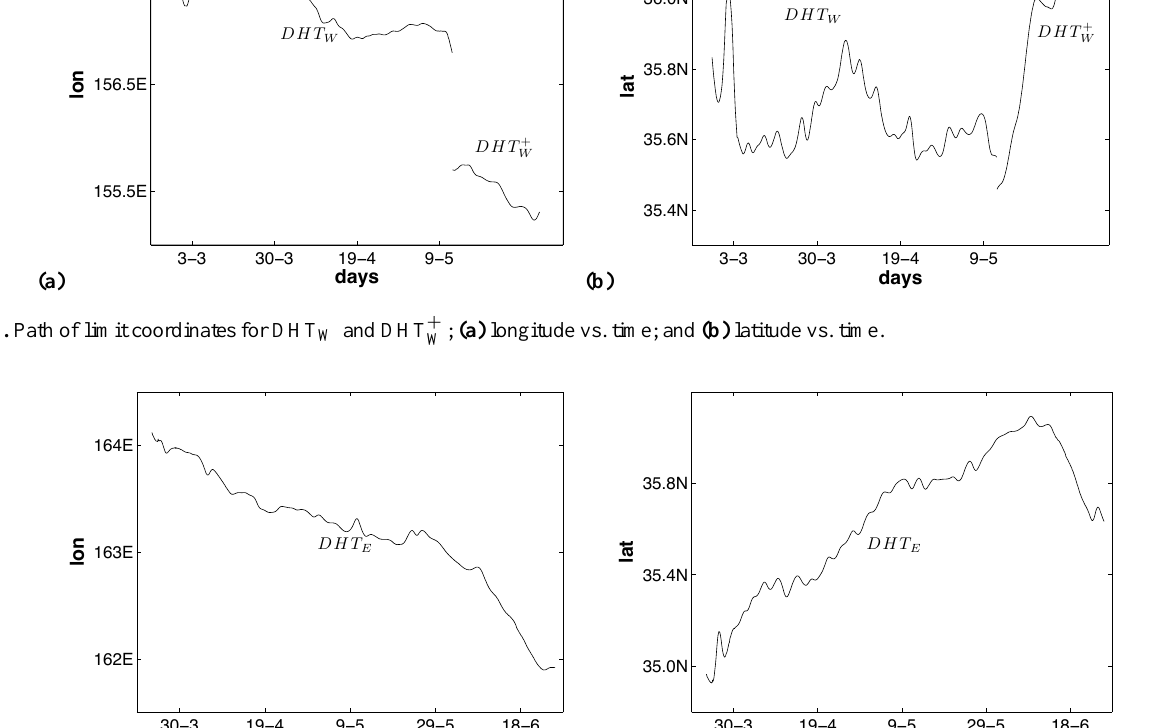
Fig. 4. Path of limit coordinates for DHT E ; (a) longitude vs. time; and (b) latitude vs. time.